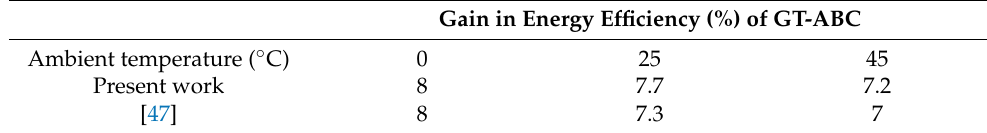
Table 11. Comparison of model results with those of